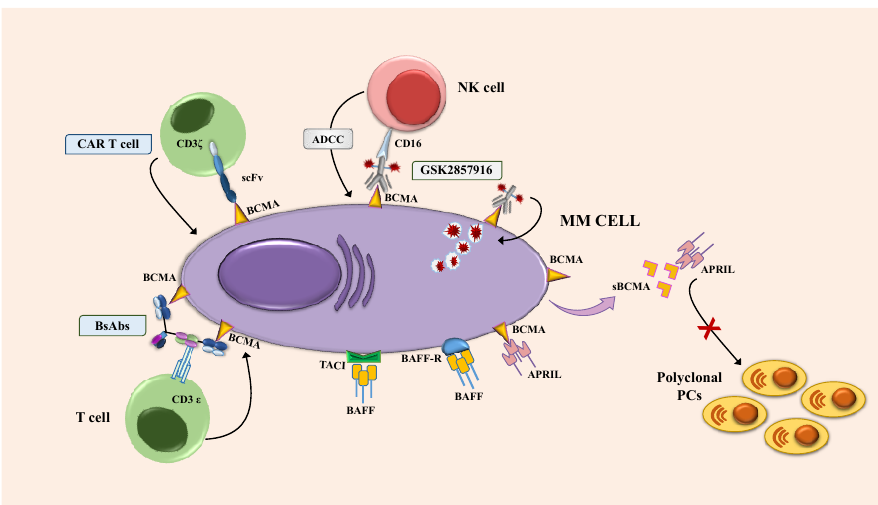
Figure 1. Immunotherapeutic approaches targeting B-cell maturation antigen (BCMA). Abbreviations: ADCC: antibody-dependent cellular cytotoxicity; APRIL: A proliferation inducing ligand; BAFF: B-cell activating factor; BAFF-R: BAFF receptor; BCMA: B-cell maturation antigen; BsAbs: bispecific antibodies; CAR T: chimeric antigen receptor T-cell; scFv single-chain variable fragment. MM: multiple myeloma; NK: natural killer; PC: plasma cells; TACI: transmembrane activator and CAML